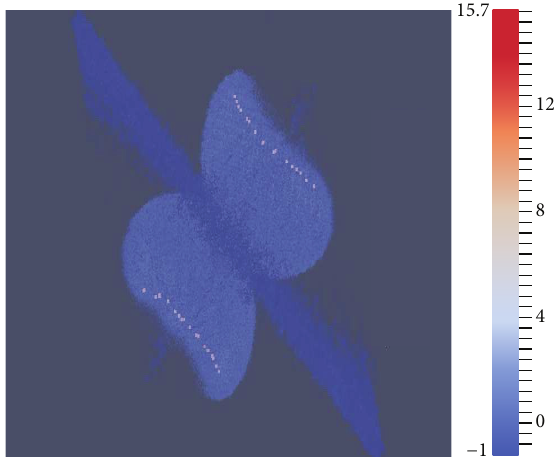
Figure 8: 3 D plot showing in red the accretion centers detected in the binary model of Figure 7 at the time 2.01𝑒4